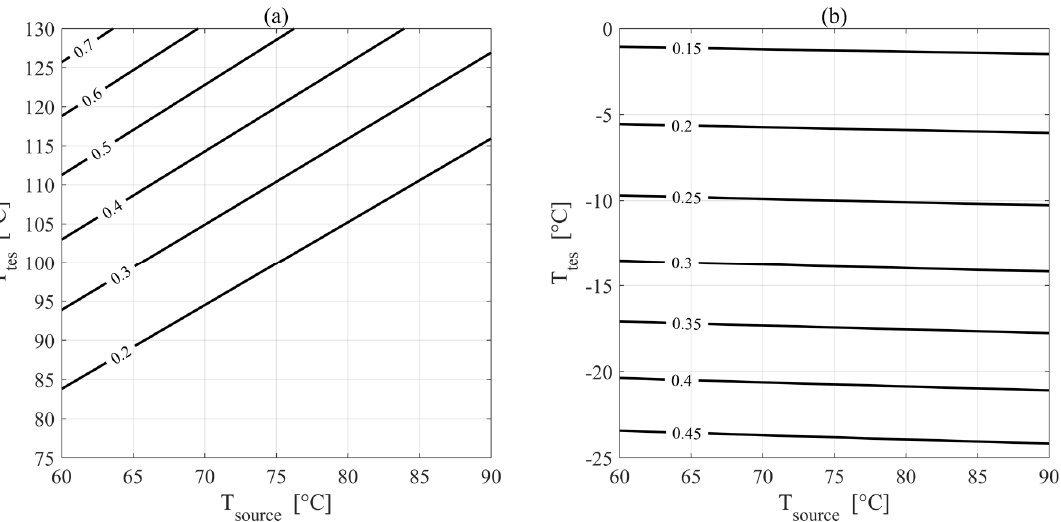
Figure 11. The ratio between electric and thermal inputs 𝑊(cid:4662) (cid:3030)(cid:3035) 𝑄(cid:4662) (cid:3046)(cid:3042)(cid:3048)(cid:3045)(cid:3030)(cid:3032) ⁄ in terms of heat source temperature T source and TES temperature T tes . ( a ) “Hot TI-PTES”; ( b ) “cold TI-PTES”.